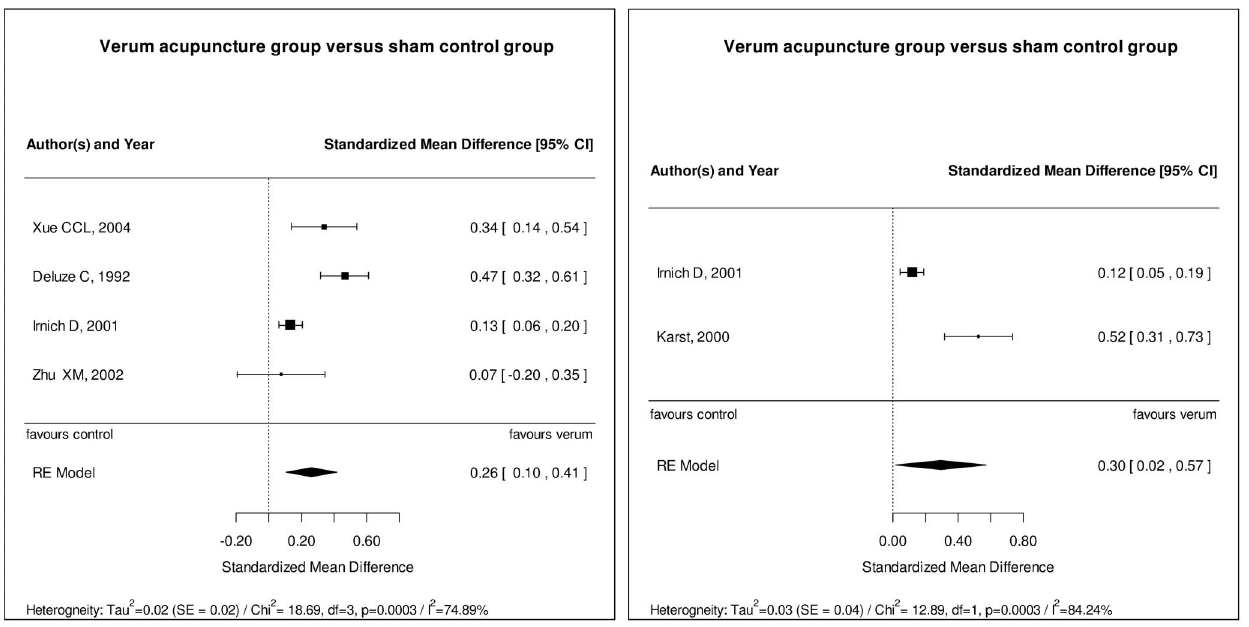
Fig. 3. Meta-Analysis. Considering the previously defined quality criteria (see methods) as well clinical homogeneity according to the investigators accordance, five studies on the effect of acupuncture on the PPTconducted with patients were combined in two meta-analyses. The short-term effect on the PPT directly after a series of acupuncture sessions as assessed in four studies (A) was found to be significant but small. Two studies were analyzed regarding long-term effects of acupuncture on the PPT (B) which was also found to be significant but small. Heterogeneity was found to be substantial in both